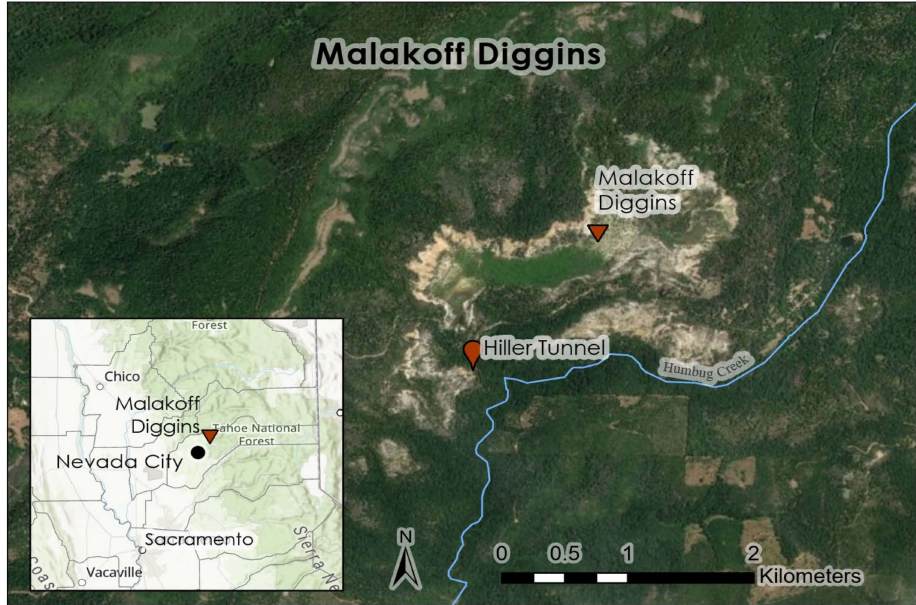
Figure 1. Map of Malakoff Diggins, including Hiller Tunnel, and the South Yuba River tributary, Humbug